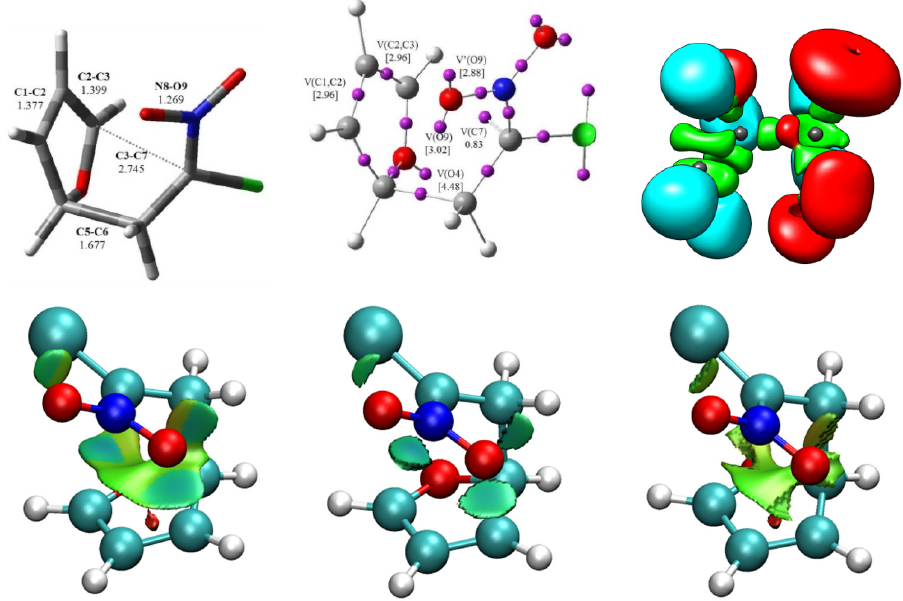
Figure 4. ELF localization domains, represented at isosurface values of ELF = 0.75, together with their attractor positions and analysis of Noncovalent Interactions (NCIs) for the transition state TS of the rearrangement of nitronic ester 1 into nitronorbornene 2 .